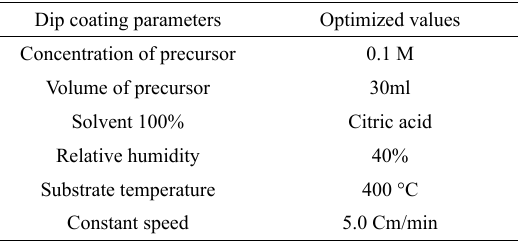
Figure 1. Schematic diagram of sol-gel process of Ni-doped Co preparation Table 1. Optimized deposition